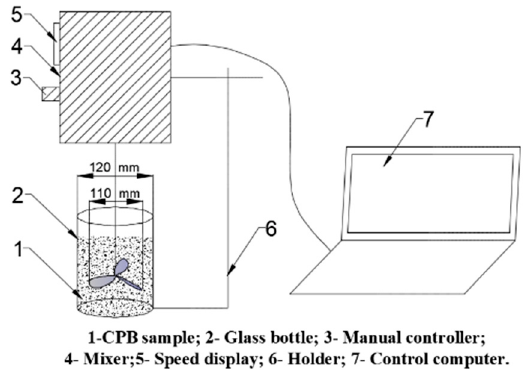
Figure 4. High-shearing-type mixer. Table 4. Estimated shear rate of the high-shearing-type mixer and high-intensity mixer. High-Shearing-Type Mixer (rpm)